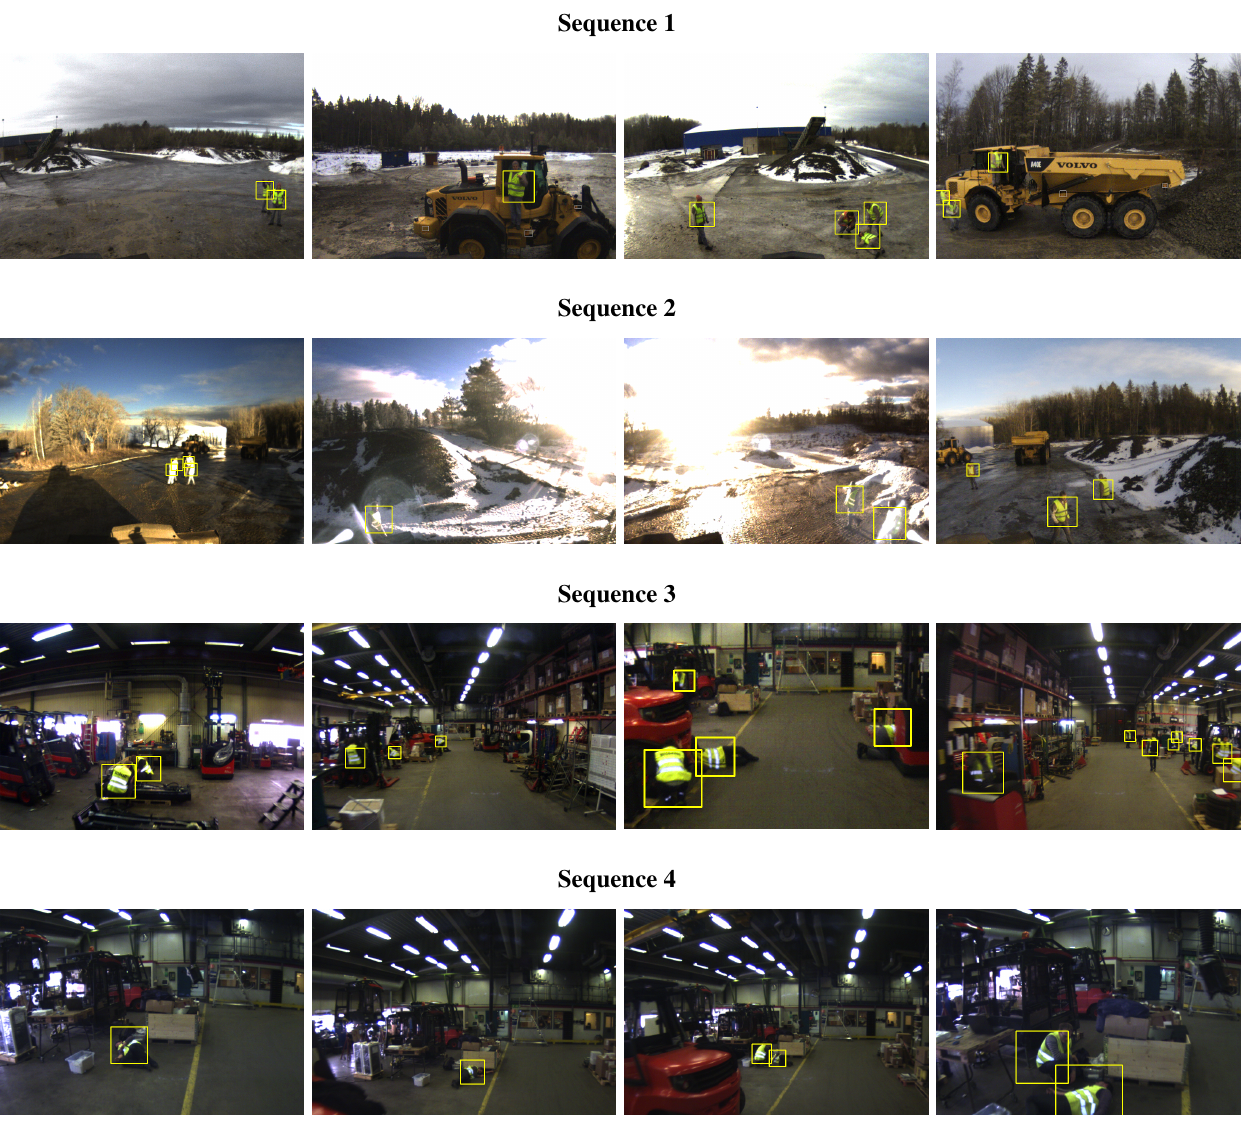
Figure 14. Exemplary tracking results for the test sequences 1–4. The detections obtained from the NIR camera are projected on the color image and indicated with a yellow square.